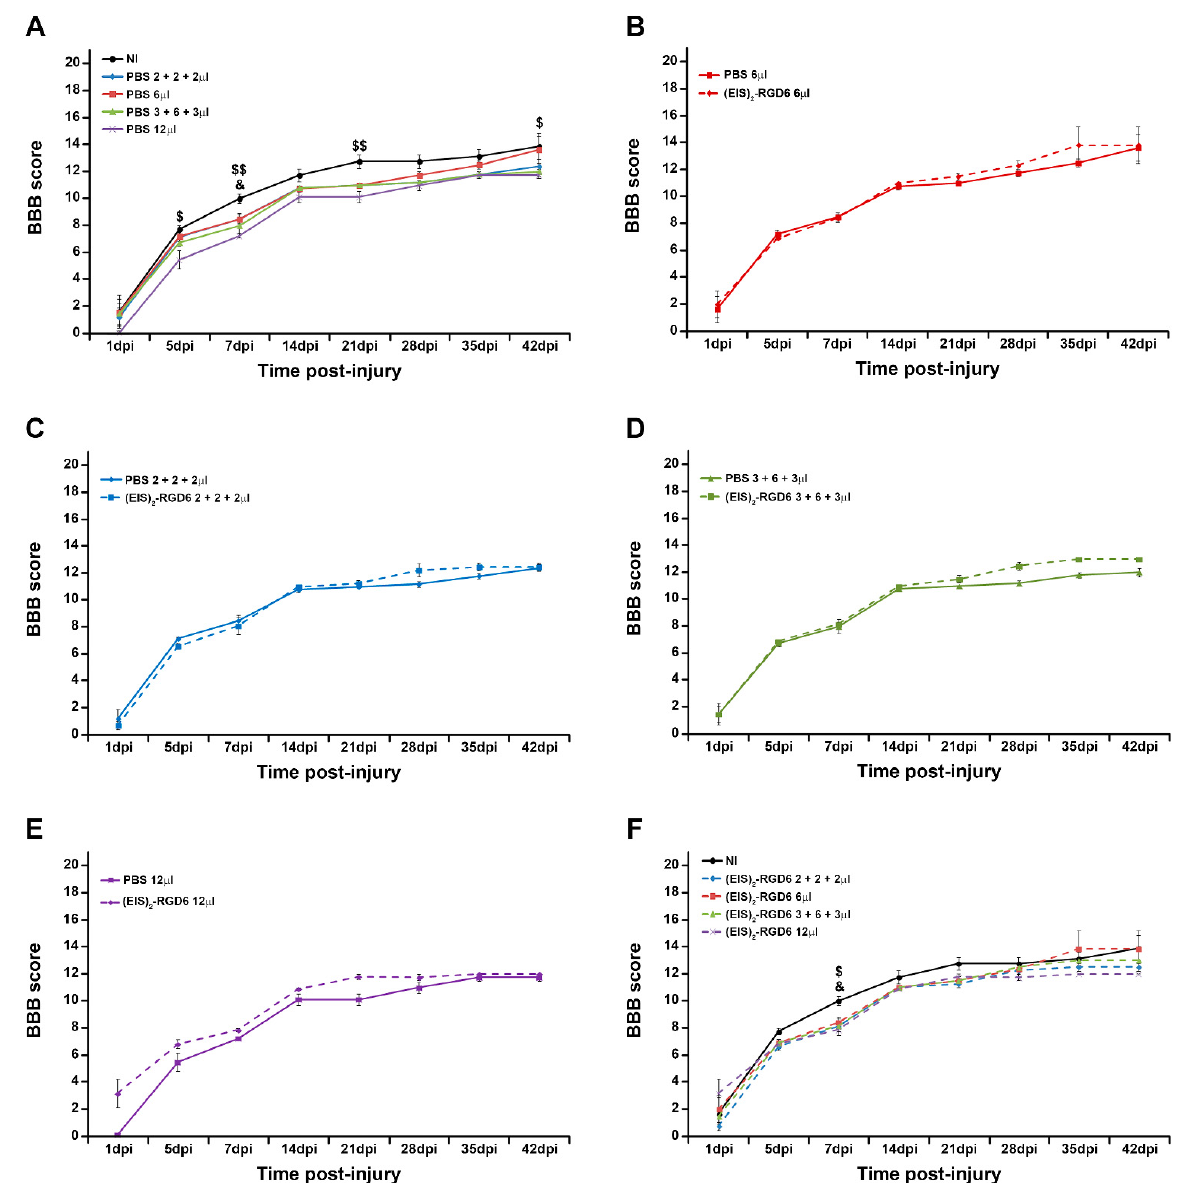
Figure 1. Determination of the injection system: 21-point Basso, Beattie, and Bresnahan open-field test (BBB) score. Graphs show data obtained from the motor functional recovery analysis using the BBB score in the experimental set performed to determine the best (EIS) 2 -RGD6 injection system [experiment (EIS) 2 -RGD6 I]. The BBB score was assessed at 1, 5, 7, 14, 21, 28, 35, and 42 days post- injury (dpi). The following comparisons are shown: ( A ) Non-injected (NI) group vs. PBS-injected groups (PBS 6 µ L, PBS 2 + 2 + 2 µ L, PBS 3 + 6 + 3 µ L, or PBS 12 µ L) (&, p < 0.05 NI vs. PBS 3 + 6 + 3 µ L; $, p < 0.05 and $$, p < 0.01 NI vs. PBS 12 µ L); ( B ) PBS 6 µ L group vs. (EIS) 2 -RGD6 6 µ L